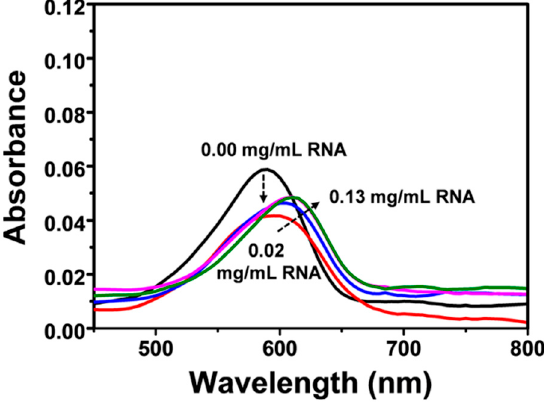
Figure 2. The influence of RNA titration on the absorption spectra of QICY (1.3 μ M) in ultrapure water.